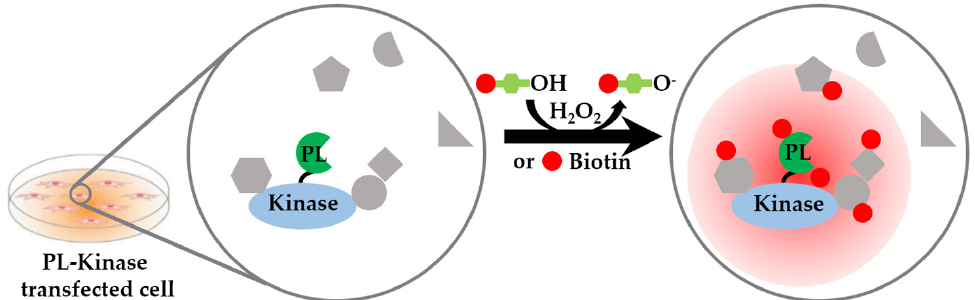
Figure 6. Kinase–substrate interaction analysis based on proximity labeling. PL enzymes are fused to the kinase of interest, which is expressed in the cells. The PL enzymes catalyze biotin-phenol or biotin into reactive biotin, which diffuses and labels proximal proteins.